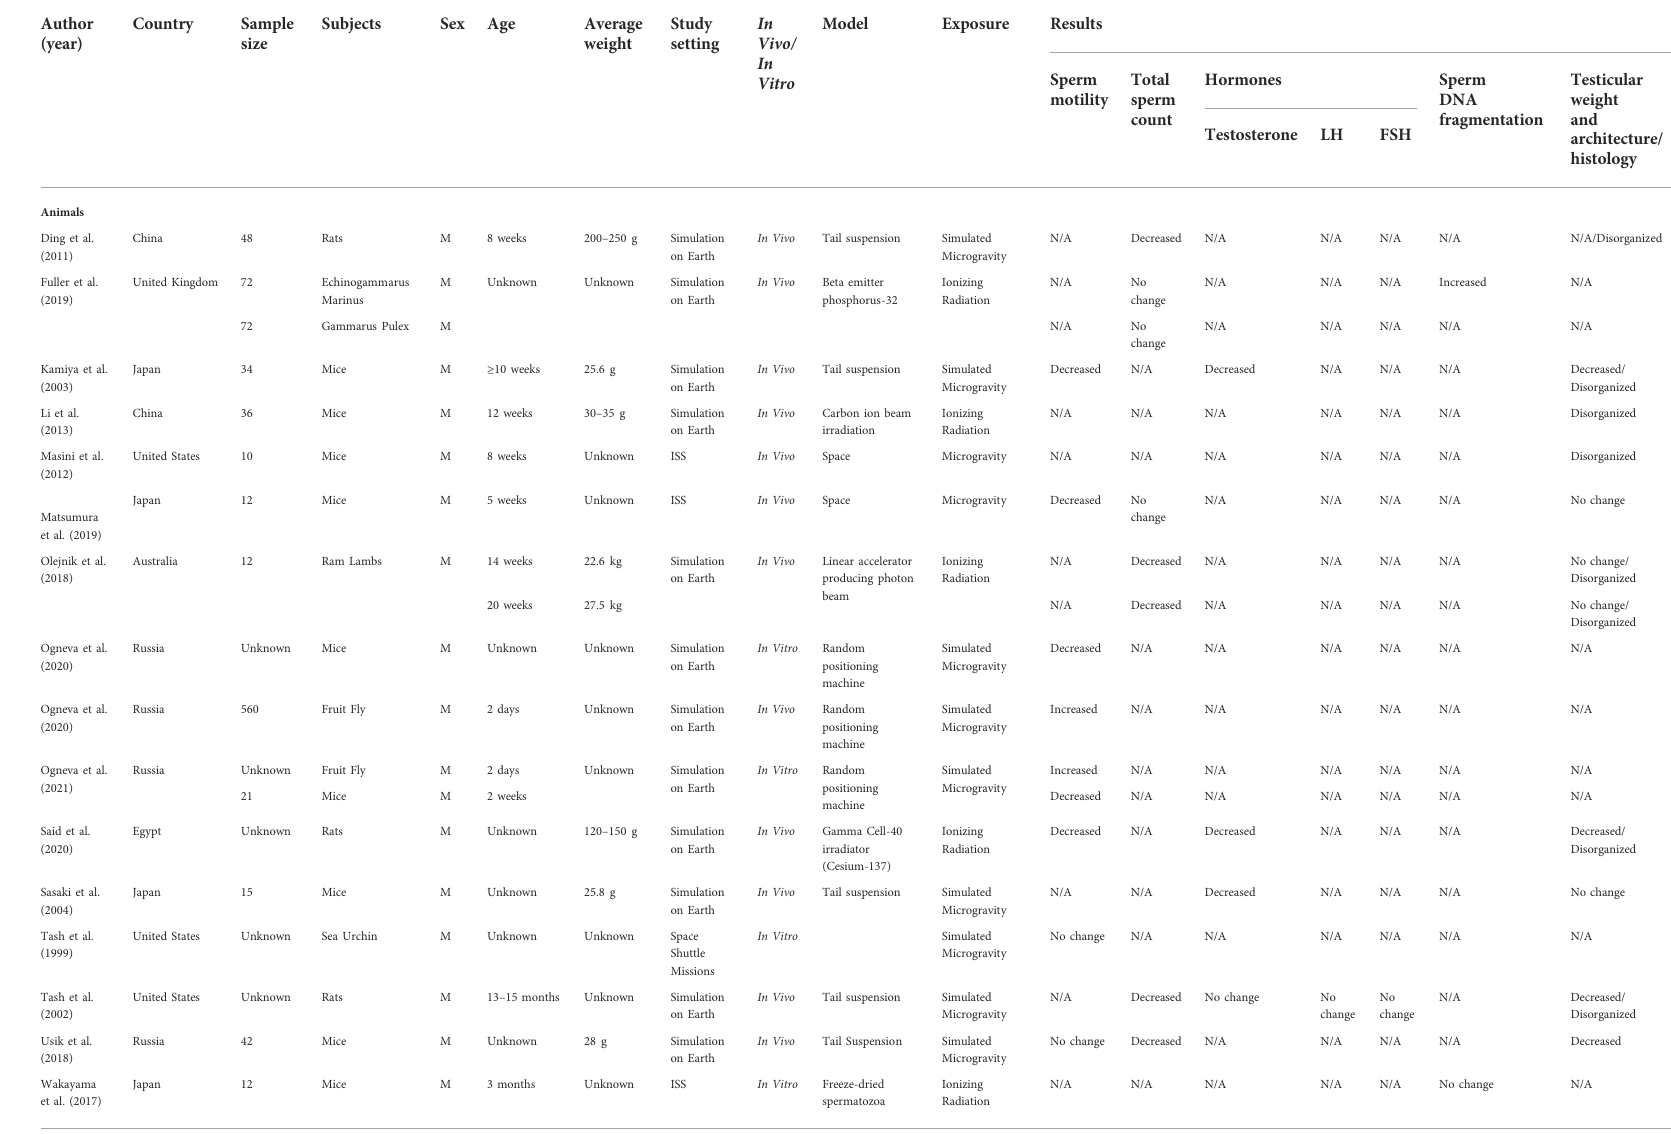
TABLE 1 Overview of fi ndings included in the current study. Studies are grouped into animal and human section. N/A = not available, M = male, LH = luteinizing hormone, FSH = follicle-stimulating hormone, g= gram, kg = kilogram.